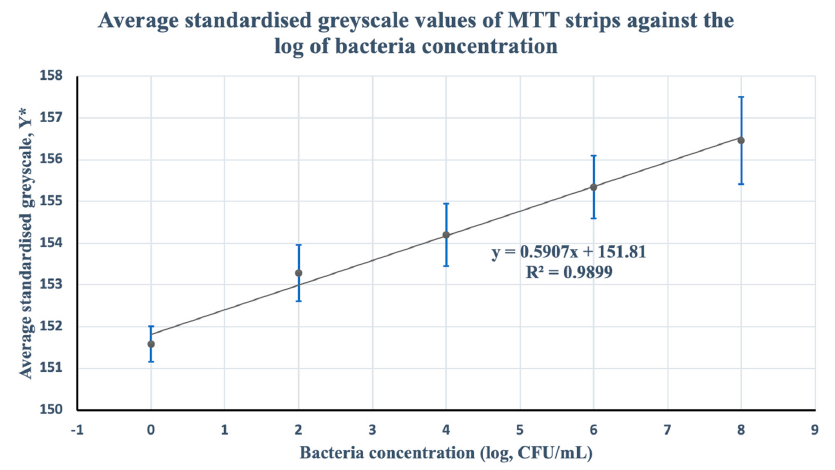
Figure 9. Mean standardized greyscale value of the MTT-PMS strips ( n = 23) in different concentra- tions of bacteria where the vertical axis represents the average standardized greyscale value from colorimetric analysis, and the horizontal axis represents the log of bacteria concentration. F-statistic of the regression against a null of no model predictive capability was found to be F = 293.85 ( p < 0.001).